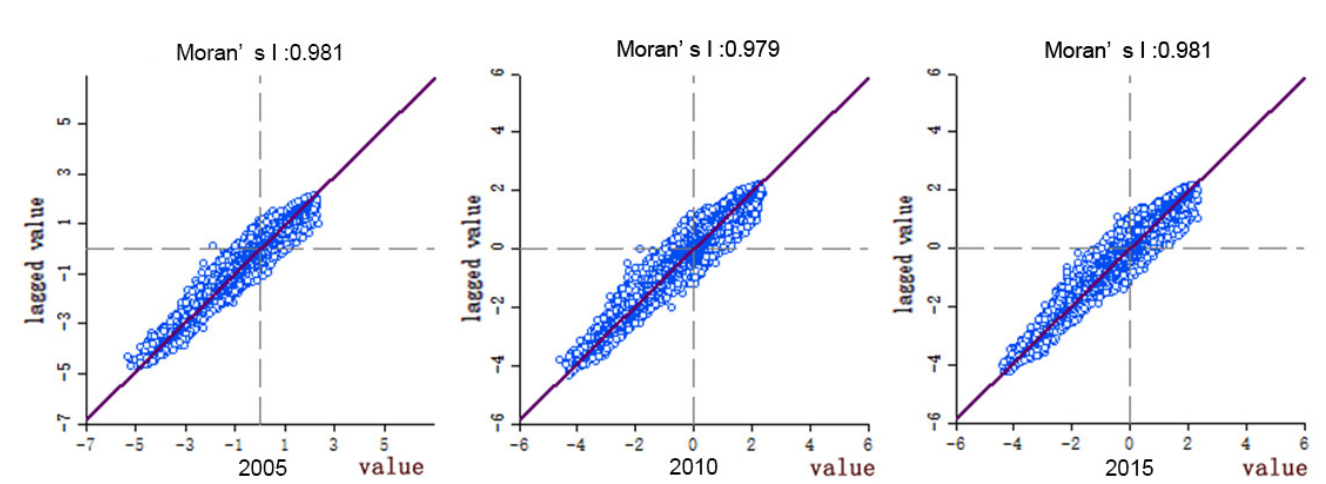
Figure 7. Moran’s I of the YRD in 2005, 2010, and 2015.